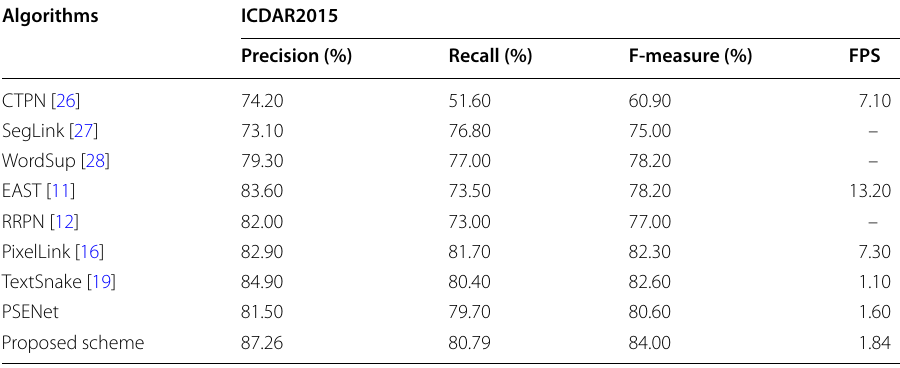
Table 3 Performance of test results on ICDAR2015, the top three related performance rankings are